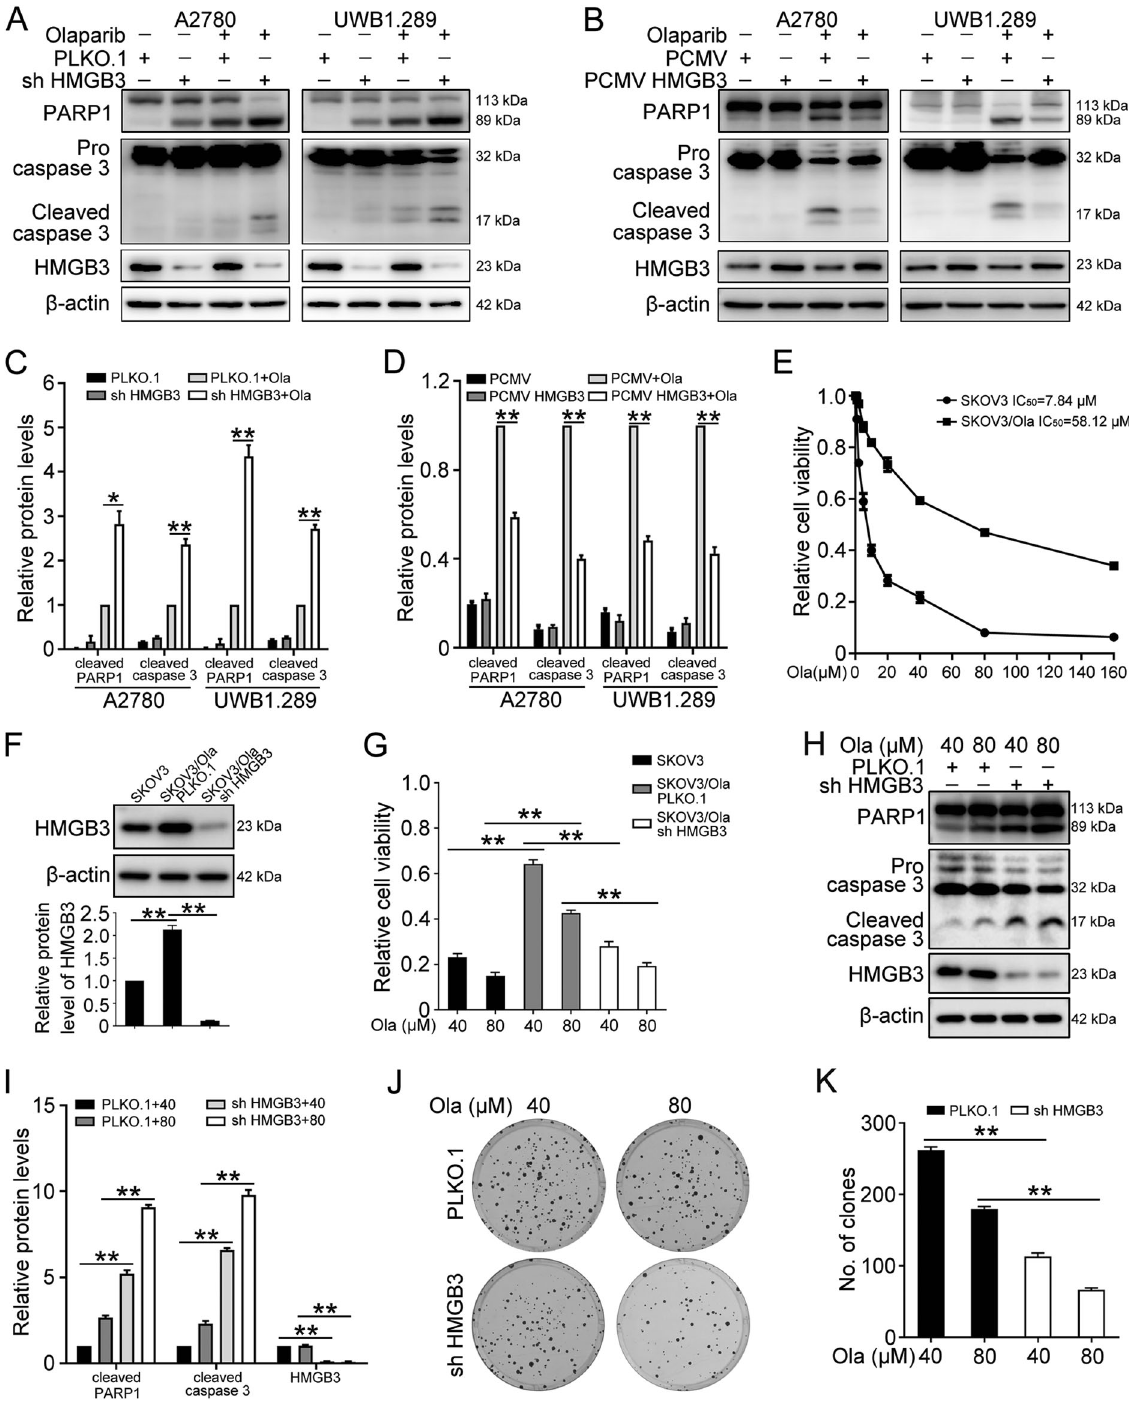
Fig. 3 HMGB3 increases olaparib insensitivity in ovarian cancer cells. A , B A2780 and UWB1.289 cells transfected with PLKO.1, HMGB3 shRNA (shHMGB3), PCMV, and PCMV HMGB3 were treated with olaparib (A2780, 4 µM; UWB1.289, 2 µM) for 72 h. Western blot was conducted to detect the protein levels of PARP1, caspase 3, HMGB3, and β -actin. C , D Quanti fi cation of the protein levels of cleaved PARP1, cleaved caspase 3, and HMGB3 in ( A ) and ( B ), respectively. E SKOV3 and SKOV3/Ola cells were treated with different concentrations of olaparib (Ola; 0, 1, 2, 5, 10, 20, 40, 80, 160 μ M) for 72 h. The MTT assay was used to determine cell viability. F Olaparib-resistant SKOV3 (SKOV3/Ola) were stably transfected with PLKO.1 or HMGB3 shRNA (sh HMGB3). Western blot was conducted to detect the protein levels of HMGB3 and β -actin in SKOV3 and SKOV3/Ola cells. G SKOV3 and SKOV3/Ola cells were treated with 40 or 80 μ M olaparib for 72 h. The MTT assay was used to determine the cell viability. H Western blot was used to detect the protein levels of PARP1, caspase-3, HMGB3, and β -actin. I Quanti fi cation of the protein levels in ( H ). J SKOV3/Ola cells transfected with PLKO.1 or HMGB3 shRNA (sh HMGB3) were treated with 40 or 80 μ M olaparib for 7 – 14 days. Clonogenic assay was conducted to assess the colony formation ef fi ciency. K Quanti fi cation of the number of clones in ( J ). (Data are presented as the mean ± SEM, * p < 0.05, ** p < 0.01, n = 3).